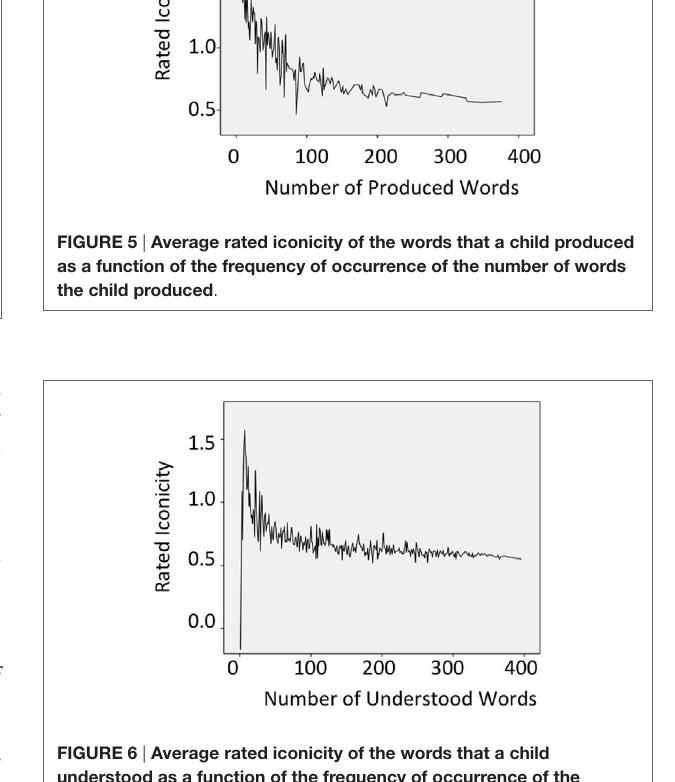
FigUre 6 | average rated iconicity of the words that a child understood as a function of the frequency of occurrence of the number of words the child understood .